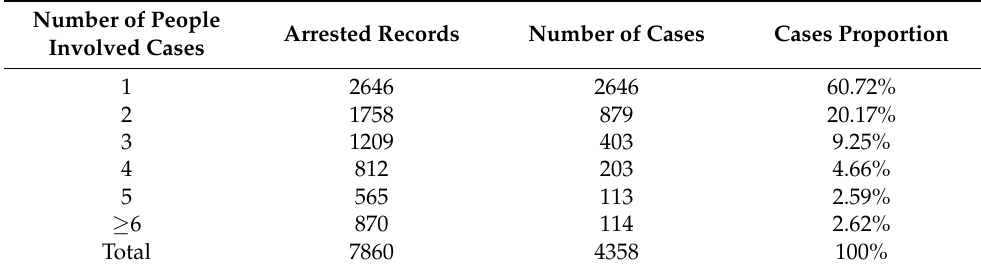
Table 1. The basic situation of street robbery cases is based on the arrest data. (N = 4358).